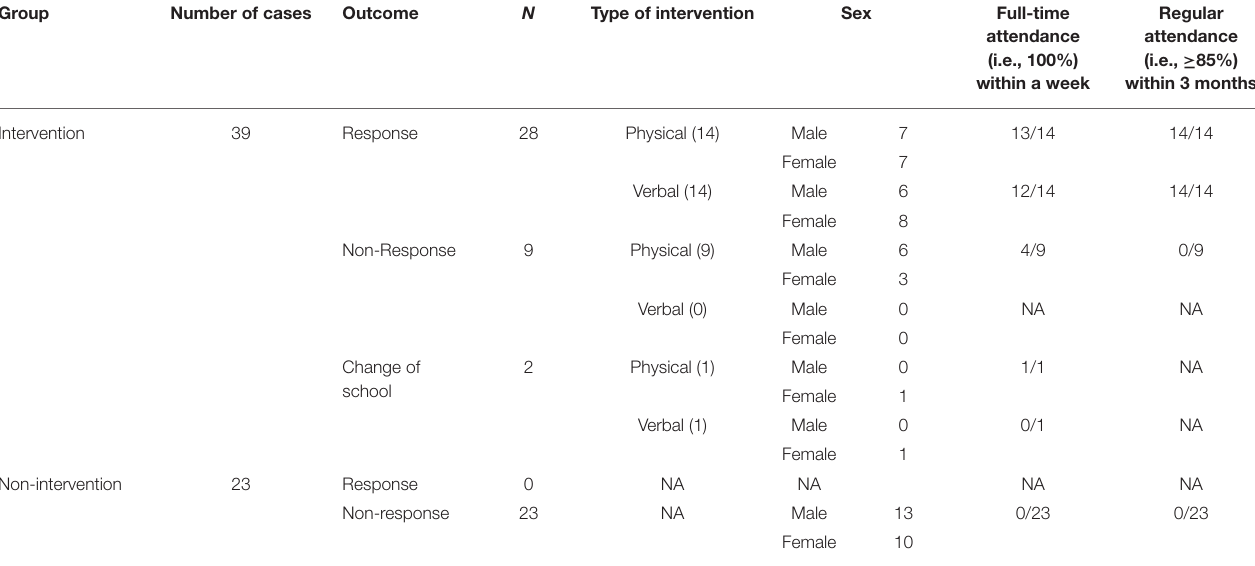
TABLE 1 | Characteristics of the return to school according to the outcome of intervention. Group Number of cases Outcome N Type of intervention Sex